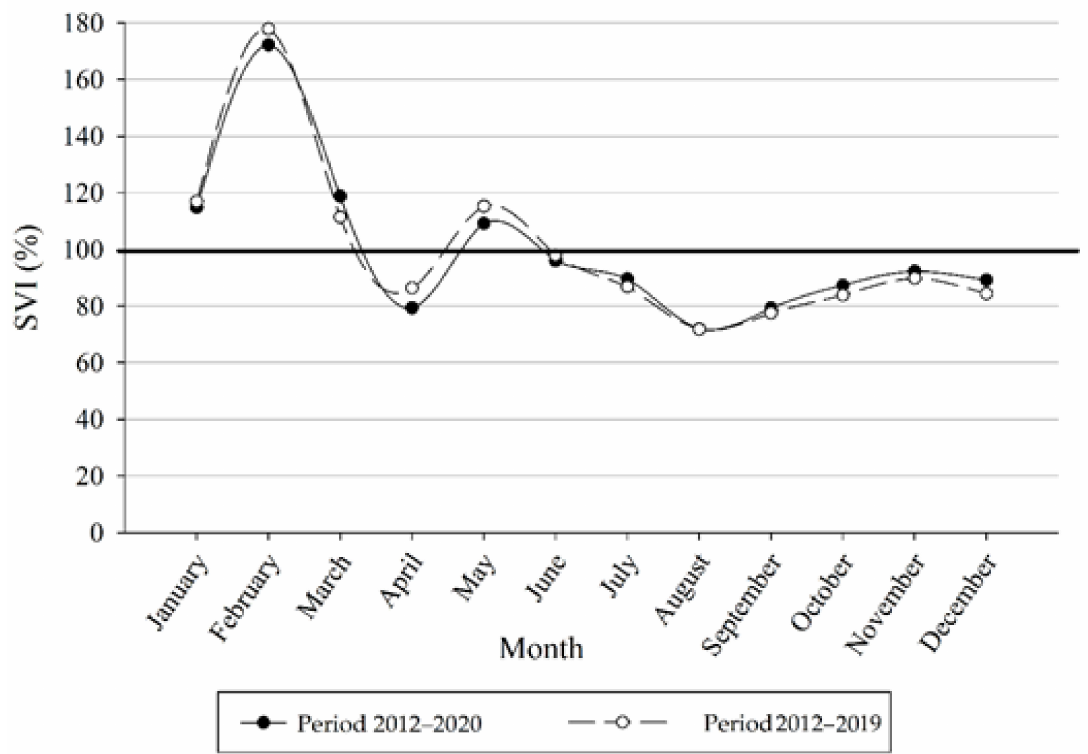
Figure 13. Seasonality pattern of vehicle disembarking traffic of the port of Santander during the periods 2012–2019